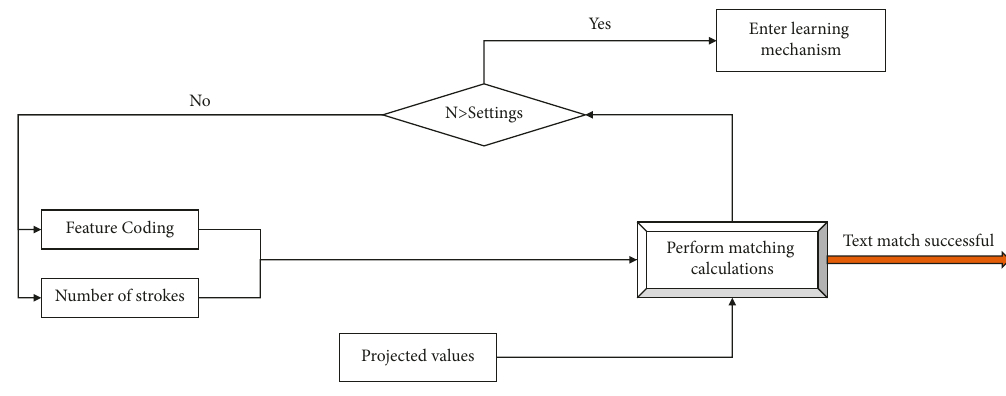
Figure 6: Classifier